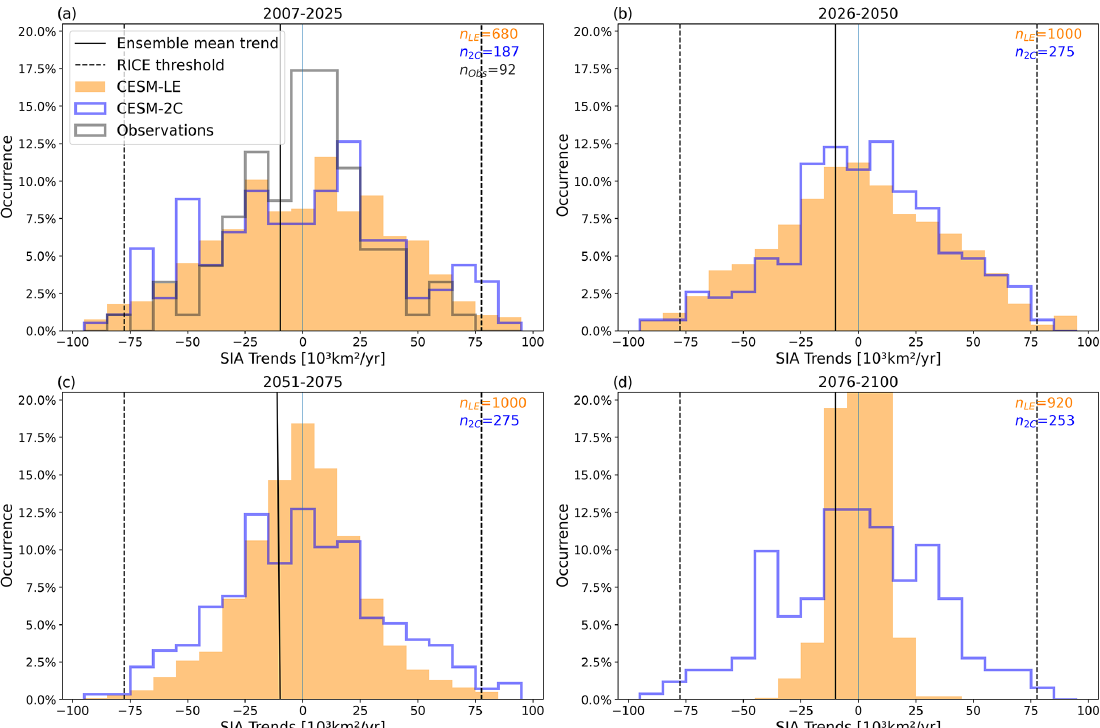
Figure 2. Histograms of internally driven 5-year trends of SIA during different time periods in the 21st century for CESM-LE and CESM-2C. The black solid line indicates the externally forced ice decline in CESM-LE (defined as the maximum 30-year trend in ensemble mean SIA, 2031–2060); the dashed lines indicate the threshold for RICEs. The sample size (number of trends) of the histograms is indicated in the top-right corner. A fourth-order polynomial was removed from observations (Walsh et al., 2017) prior to calculating trends to represent the externally forced signal (following Bonan et al.,